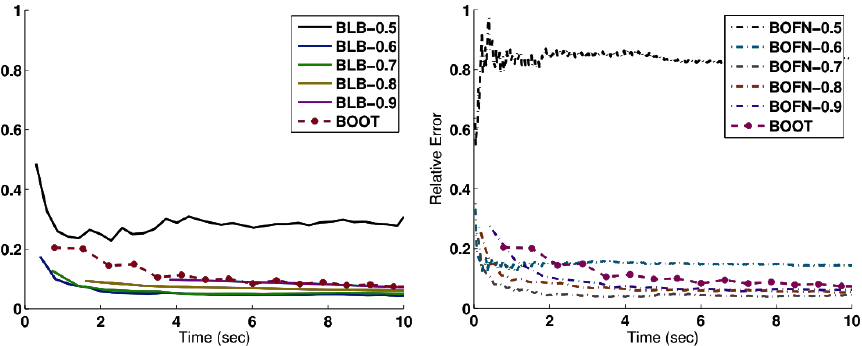
Figure 9. Single-threaded results on a subset of the data. b = n γ for multiple values of γ ∈ [ 0.5,1 ] and r = 100 is used. s is not fixed and grows over time.